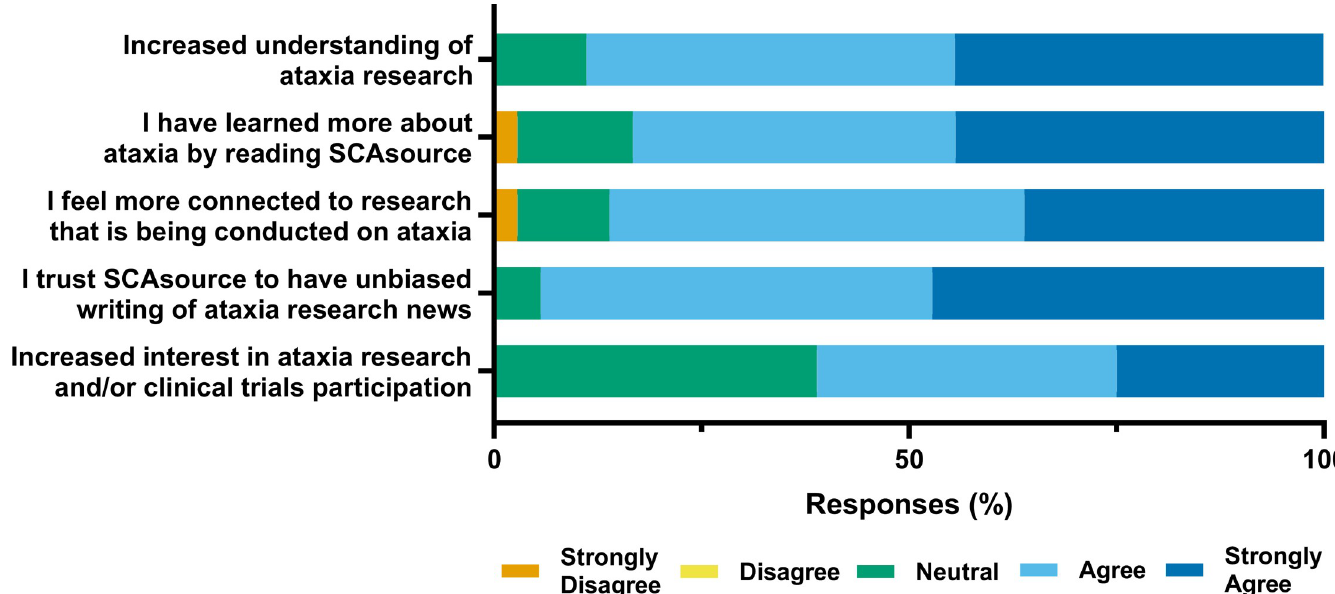
Fig 3. SCAsource reader self-reported outcomes. Respondents were asked to rate their agreement about whether reading SCAsource content resulted in the above statements using the indicated 5-point Likert-type scale.